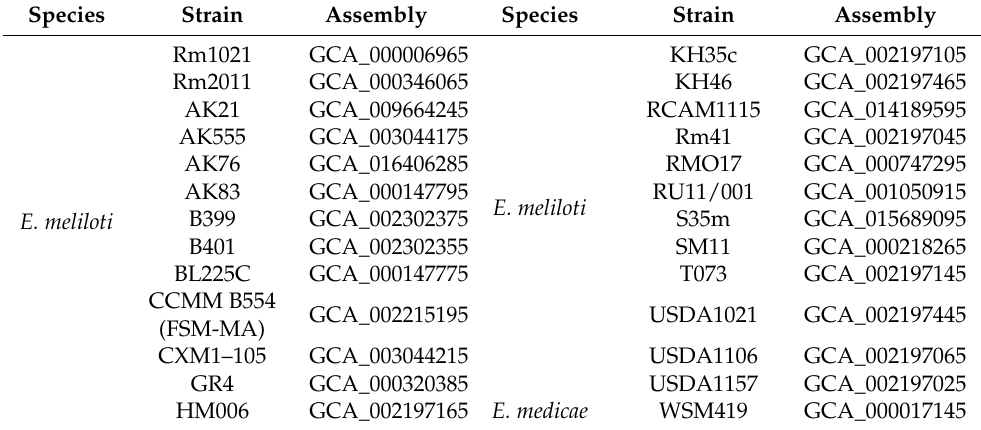
Table 1. The genome sequences of Ensifer spp. strains used for